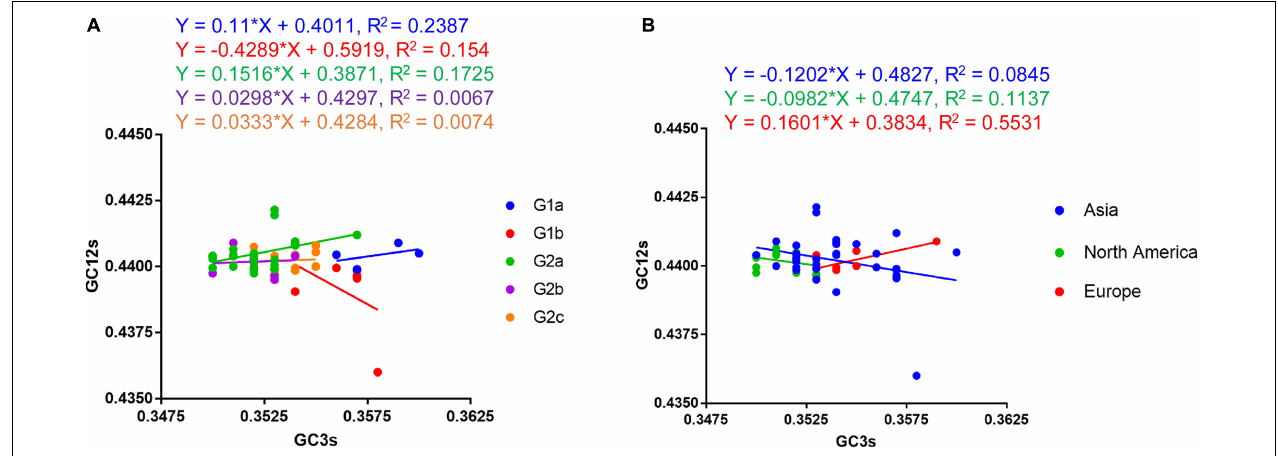
FIGURE 6 | Neutrality plot analysis (GC12s against GC3s) of the PEDV complete coding genes. (A) Plot according to phylogroups. (B) Plot according to continent. The regression line is represented by the corresponding straight line, and the regression equation is also shown. The slope value indicates the mutational pressure. The neutrality plot shows the correlation between GC content in synonymous positions (GC12s) and GC content in non-synonymous positions (GC3s).